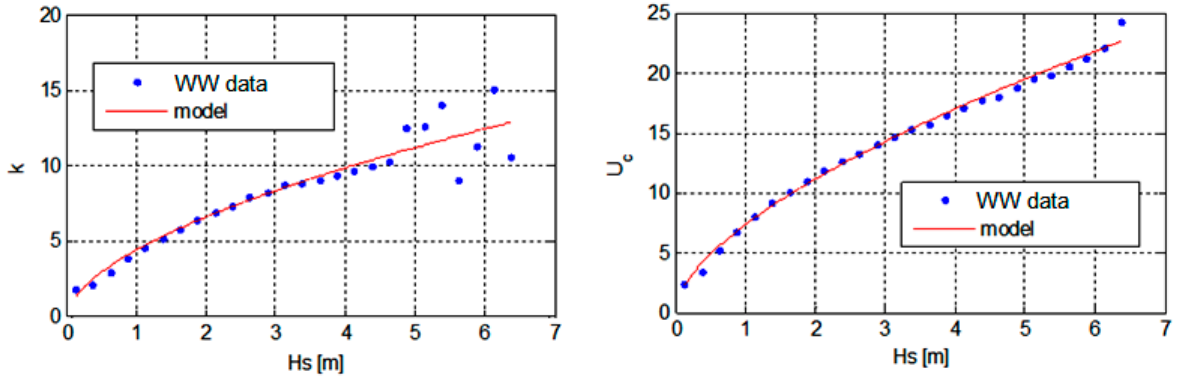
Figure 11. Fitting the model to WW data; entire Adriatic; Hs,i = 2.25–2.5 m. By repeating the same procedure for each H s,i bin, a model of fit parameters k and U c is obtained. Their results for the entire Adriatic are presented in Figure 12 as a function of H s .